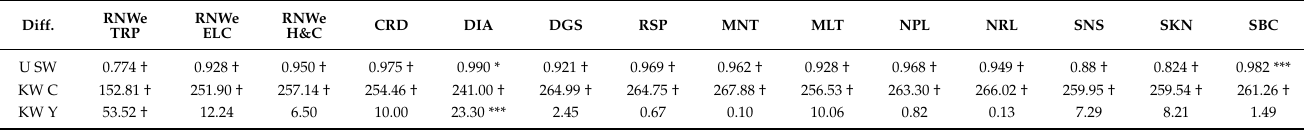
Table 2. Normality and differences tests—countries and